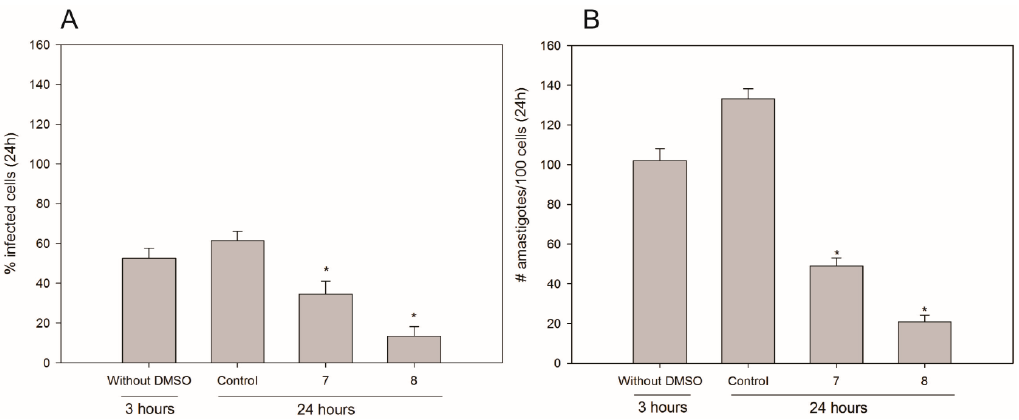
Figure 4. Leishmanicidal activities of compounds 7 and 8 in infected RAW macrophages. The percentages of infected macrophages ( A ); and the numbers of intracellular amastigotes per 100 cells ( B ) were assessed. The first column (without DMSO) is the control after 3 h of infection and before the addition of 1% DMSO. The second column is the sample assay after 24 h of infection in the presence of DMSO. The last two columns are the samples with isobenzofuranones 7 and 8 at the concentration of 75 µM in 1% DMSO. The data are presented the averages and the SDs of three independent experiments that were performed in triplicate. The * indicates significant differences compared with the control at p < 0.05.